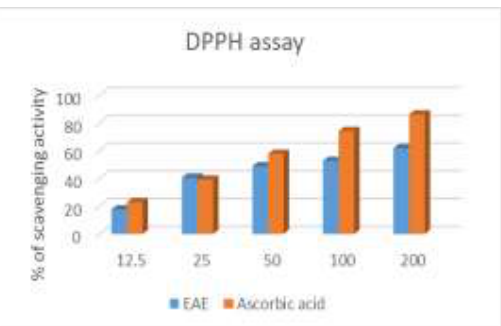
Figure 5. The 1 HNMR spectrum of C1 The results of the different chromatographic techniques and various spectral analysis proved that the compound 1 was beta-sitosterol.